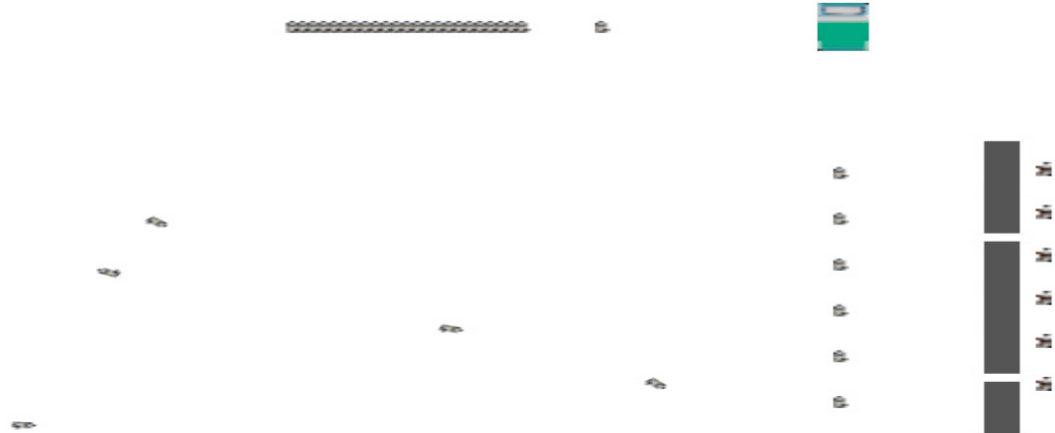
Figure 39. AnyLogic Patient-Doctor Simulation 2D Model in Execution (top viewpoint).